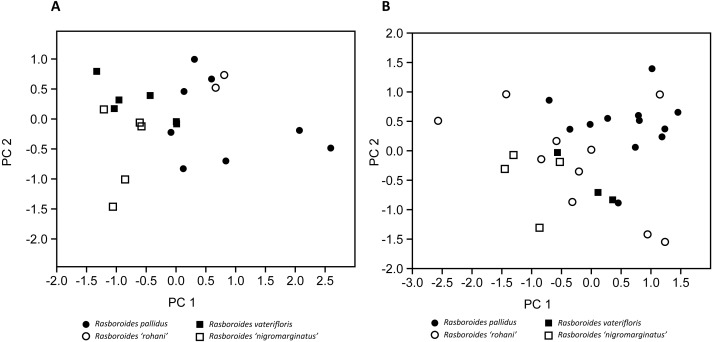
Plot of scores from the principal component analysis of size corrected measurements from putative species of (A) females, and (B) males of Rasboroides in Sri Lanka.